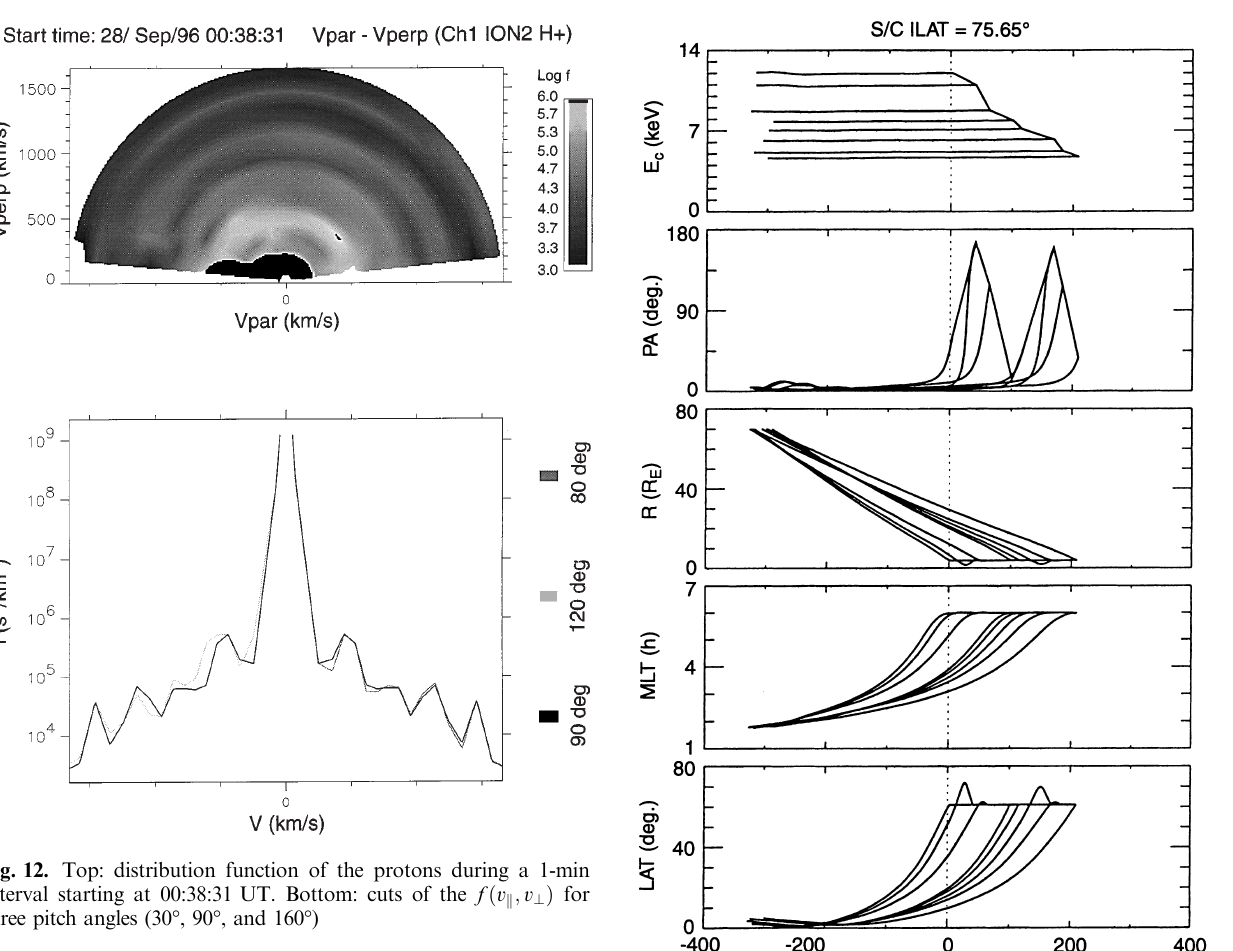
; v ? (cid:134) for k